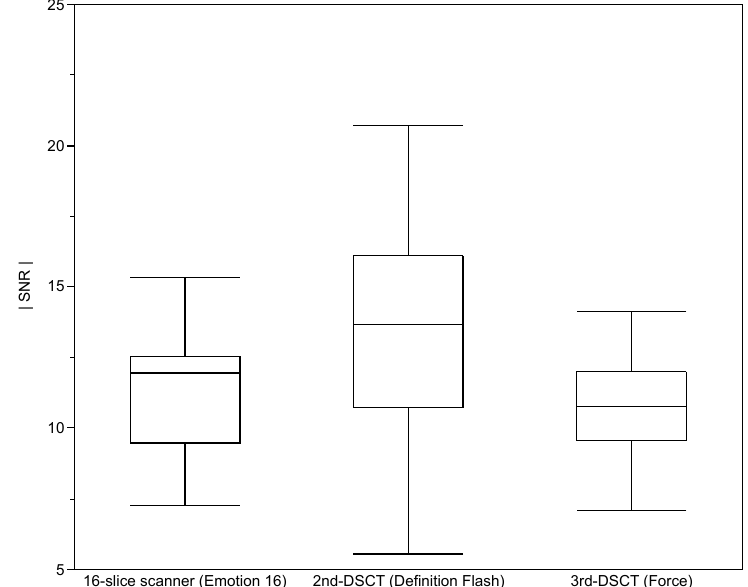
Figure 2. Signal-to-noise ratios for a representative lung region evaluated from CT scans acquired at the three CT systems in inspiration using the three protocols summarized in Table 1. Box-and-Whiskers-Plot representation after Tukey [24].